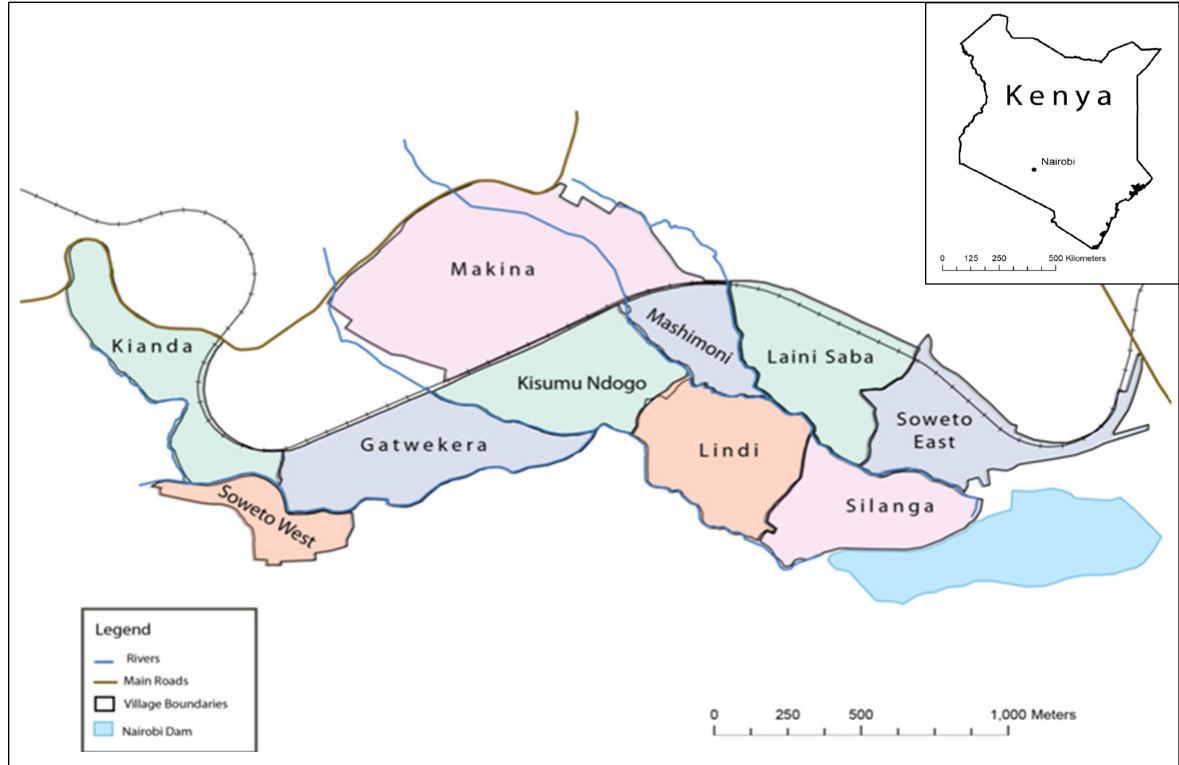
Figure 1. Map of the Kibera Slums in Nairobi, Kenya Approximately 500,000 people reside in this slum, where thousands of households are now involved in sack gardening. The Kibera slum is divided into its own neighborhoods. Our research was carried out in the villages